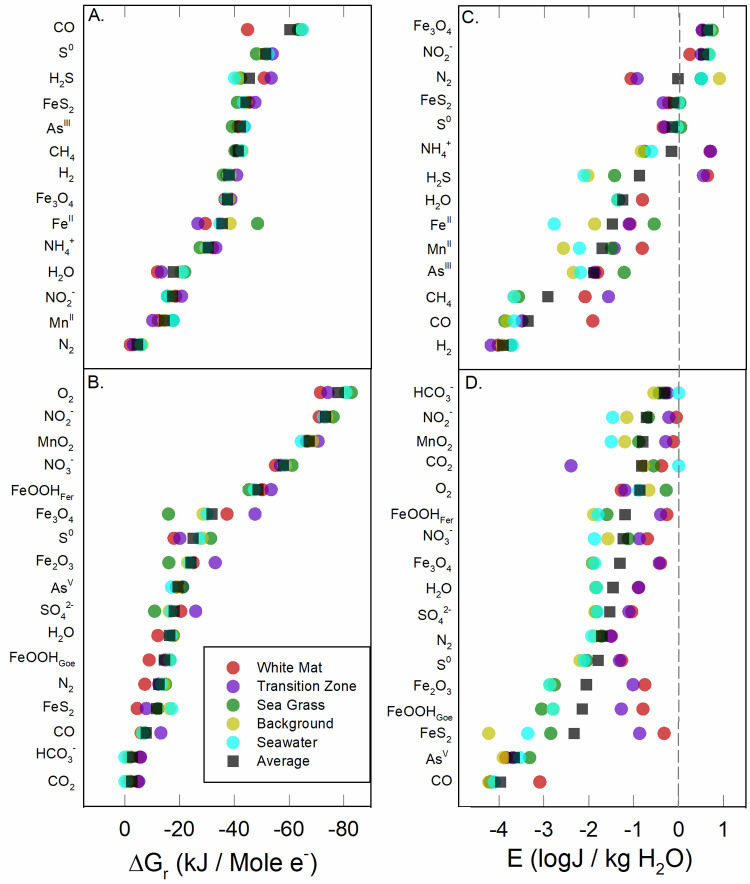
Average Gibbs energy yields of exergonic reactions.Average values of ΔGr (panels A and B, in kJ/mol e-) and Efluid (panels C and D, in J/kg H2O) grouped by electron donors (panels A and C) and electron acceptors (panels B and D) for the five biogeographic regions considered in this study.